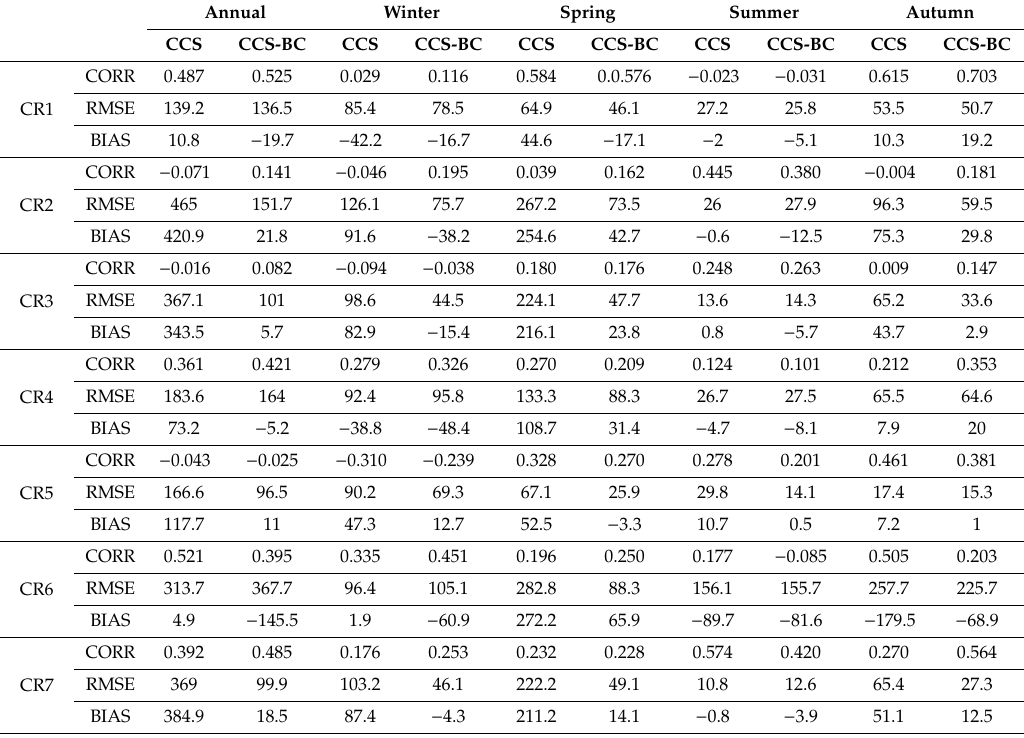
Table 3. Quantitative results of the spatial evaluations for the mean annual and mean seasonal precipitation of the CCS and CCS-BC compared to the gauge observations for the seven CRs for the validation